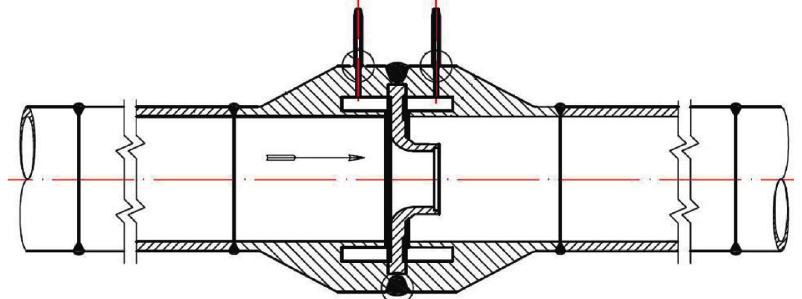
Figure 5: Two-dimensional drawing of nozzle flowmeter.